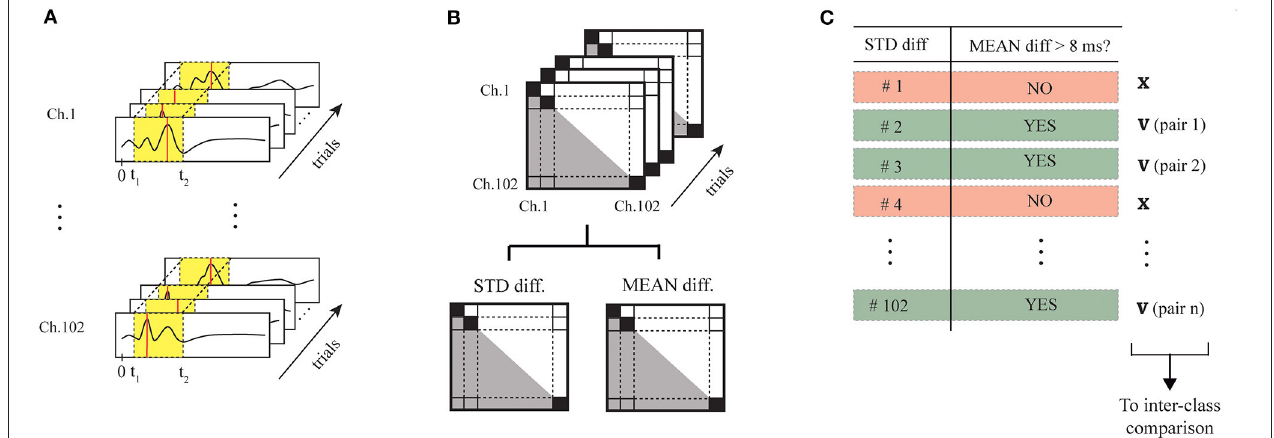
FIGURE 10 | Processing pipeline for the selection of the eight informative magnetometers. Considering the time series during the window of interest (in yellow), we executed the following steps first for the No-Go trials and then for the Go trials: (A) detected the maximum peak on each MEG channel, for each of the trials; (B) we computed the time difference considering each combination of magnetometers, and extracted mean and standard deviation of the time difference on each pair of MEG sensors along the trials; (C) we selected the couples of sensors starting from those characterized by the lowest standard deviations and a mean ≥ 10 ms . Inter-class discriminative power has been then guaranteed by comparing the 2 sets of sensor couples selected for the 2 classes, and removing possible pairs of sensors duplicated in the 2 classes if they presented the same mean.